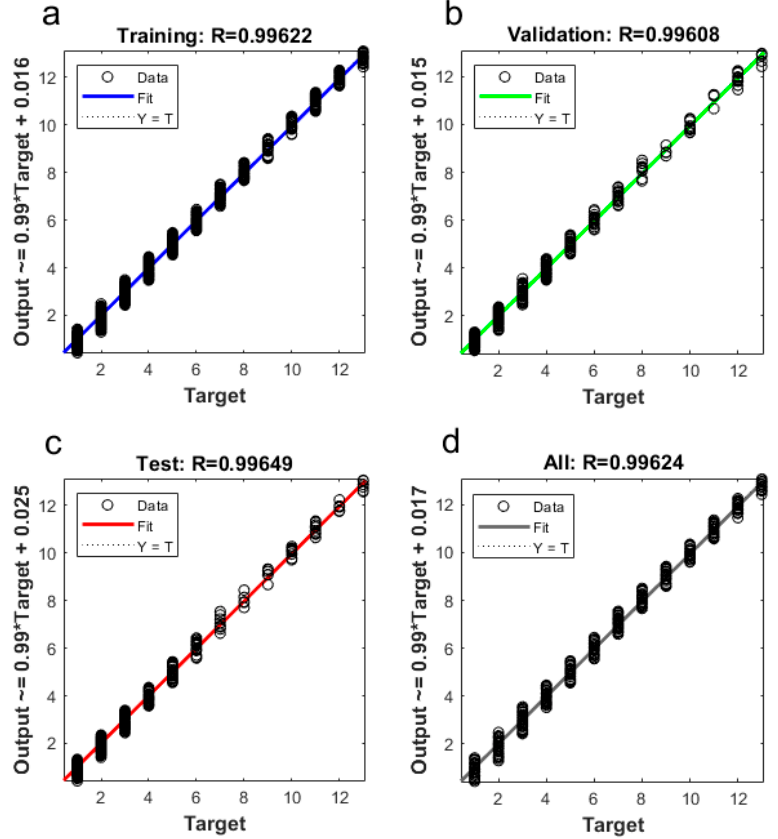
Figure 6. Input–output correlation in the newly developed BP neural network model for identifying broiler chicken floor distribution ( a , b , c , and d correspond to the training set, validation set, test set and overall results, respectively. The horizontal axis Target is the actual number of chickens; and the vertical axis Output is the number of BP model output; “O” represents the input data of the model; “Fit” is the fitting relationship between input and output; “Y = T” means the training output value equal to the target value).